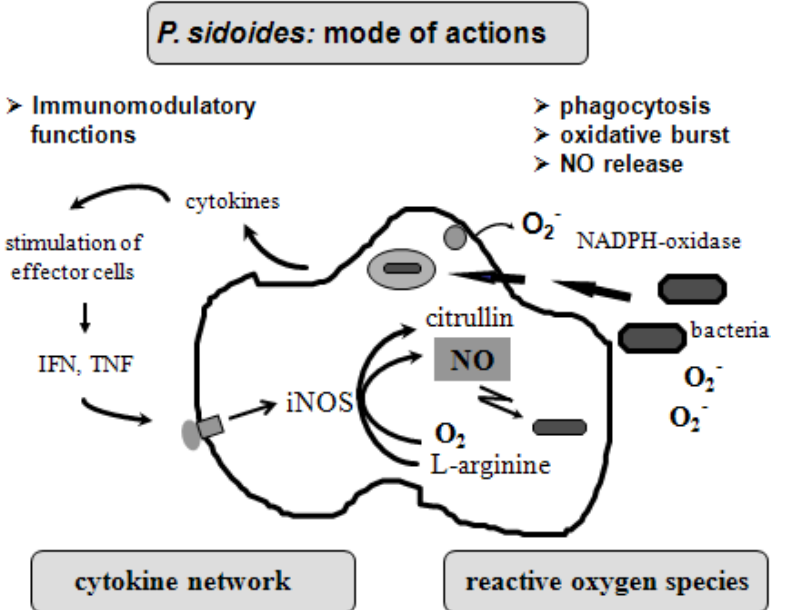
Figure 3. Simplified illustration of cytotoxic defence mechanisms of activated macrophages induced by the root extract of P. sidoides